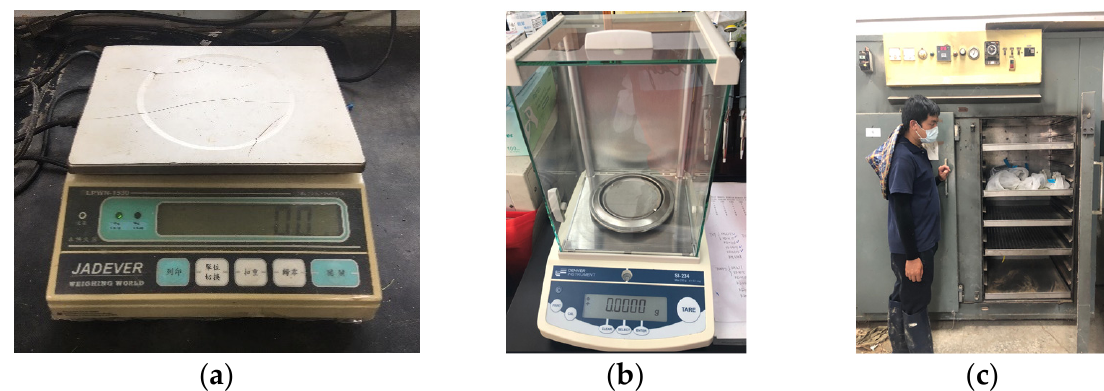
Figure 5. Multi-day GMC dataset grain weight was measured by JADEVER LPWN-1530 ( a ) and image-based GMC dataset